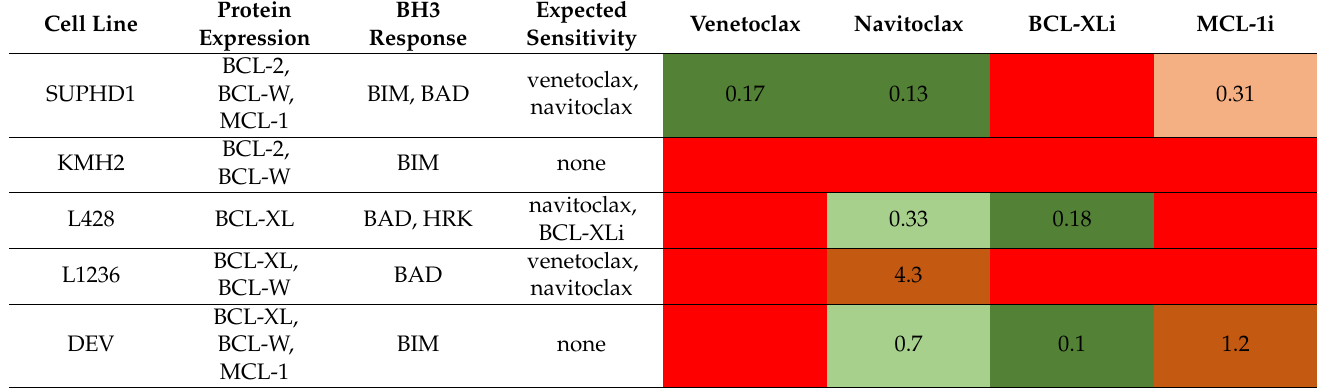
Table 2. Overview of the results on the cell lines of expression of BH3 proteins and sensitivities for